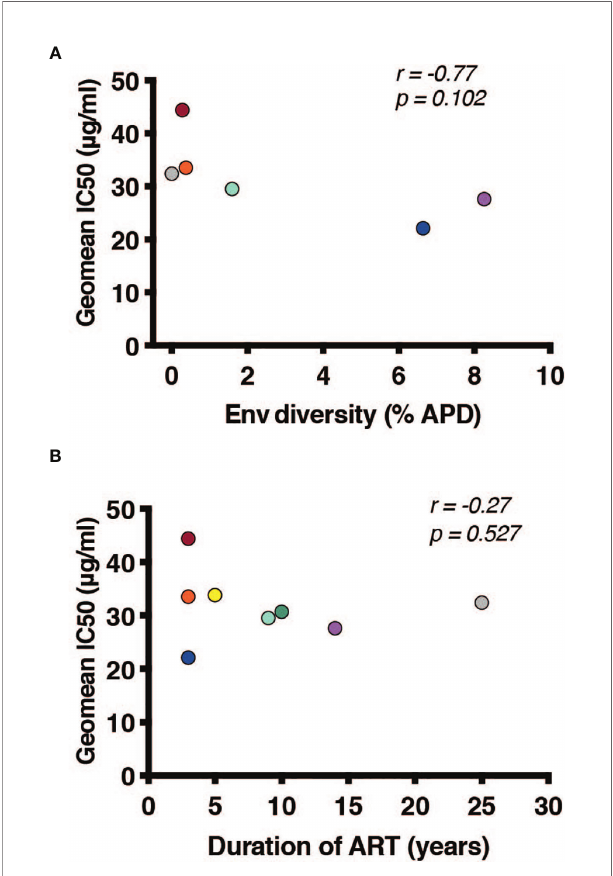
FIGURE 4 | Duration of infection and reservoir diversity are associated with neutralization of global HIV-1 viruses. Geometric mean IC 50 of IgGs against a global HIV-1 reference panel were calculated for each individual and graphed against (A) Env diversity and (B) duration of ART. Correlations were calculated by nonparametric